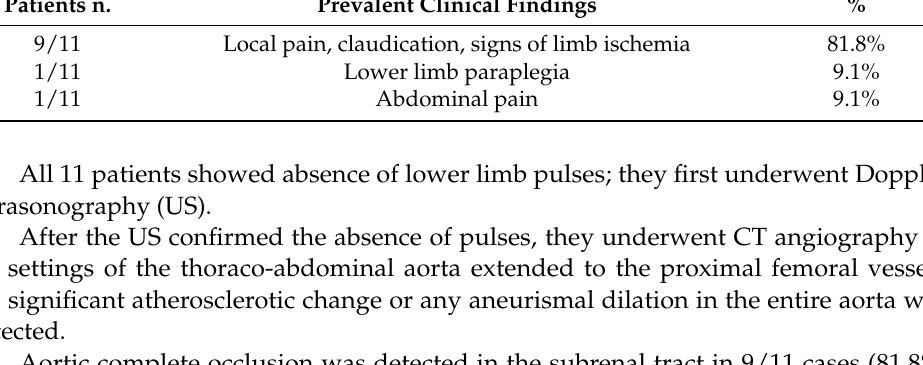
Figure 2. ( A ). CT angiography, coronal planes, arterial phase, MIP reconstruction. Aortic complete occlusion in the subrenal tract. Thrombosis located also in the left renal artery and extended until left common femoral artery can be noted (in our study found in 3/11 patients). ( B ). CT angiography, coronal planes, arterial phase. Aortic complete occlusion in the infrarenal tract, located at the origin of the right renal artery.